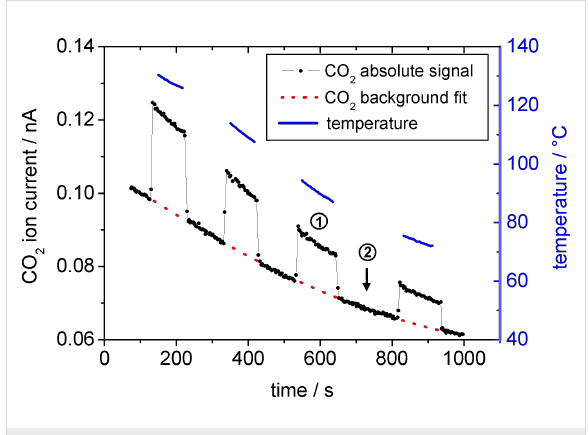
Figure 2: Principle of the SMS measurement on the mesoporous Au/TiO 2 film with CO oxidation as a test reaction. The CO 2 signal was measured for decreasing sample temperature (blue data) atop the catalytically active layer (1) and the bare Si reference